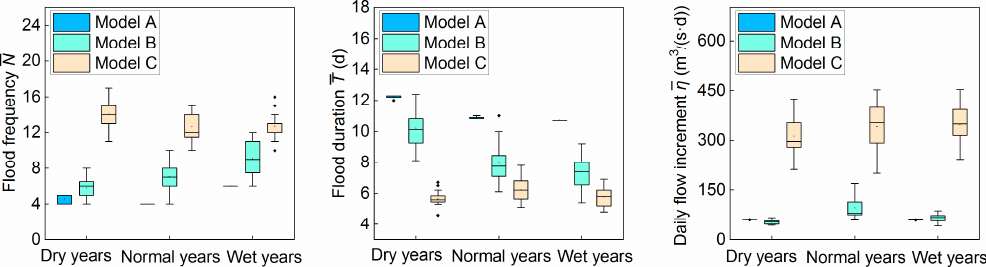
Figure 6. Box diagram of characteristic parameters of flow rising process in 20 operational results. Table 6. Comparison of three ecological